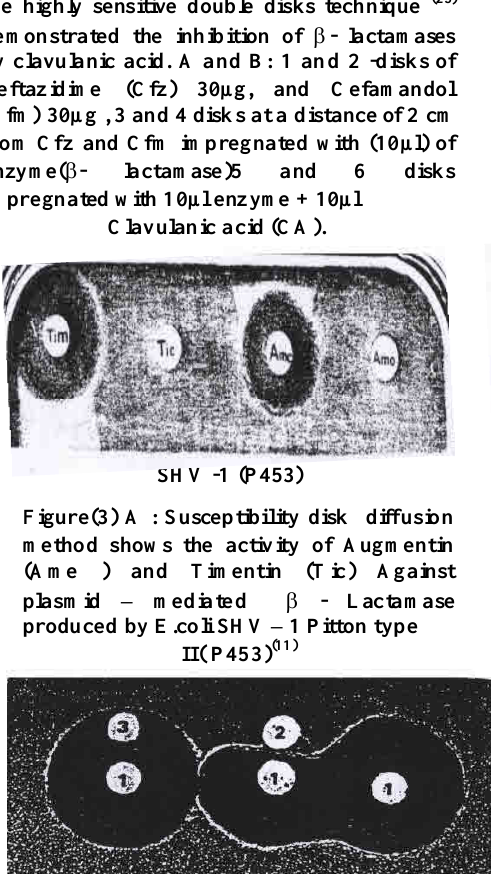
Figure (3) B : Action of inhibitor clavulanic acid (CA ) on the activity of standard  - lactamase extracted from E.coli SHV-1 Pitton type 1: Ampicillin , 2:  - Lactamase 3:  - Lactamase+clavulanic acid.